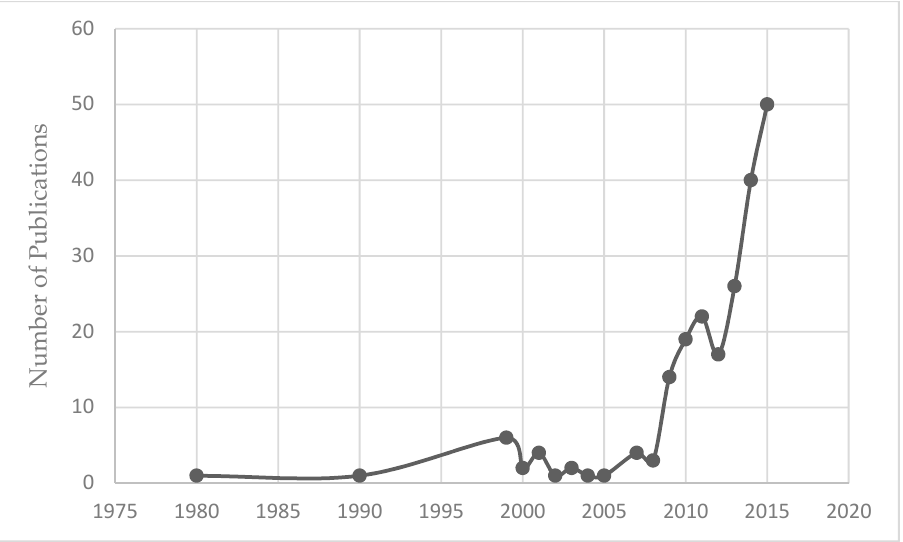
Figure 1. The number of publications authored by “independent researchers” every year.